Question: In one sentence, what is this figure communicating?
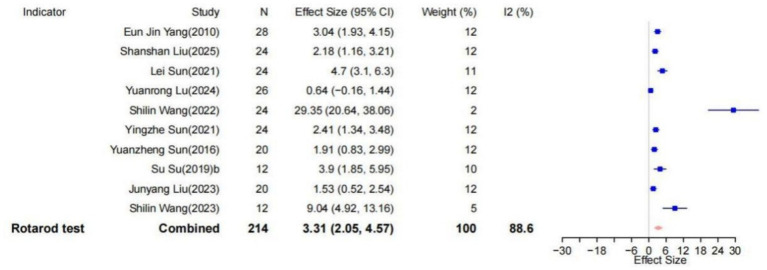
Answer: Rotarod test forest plot.